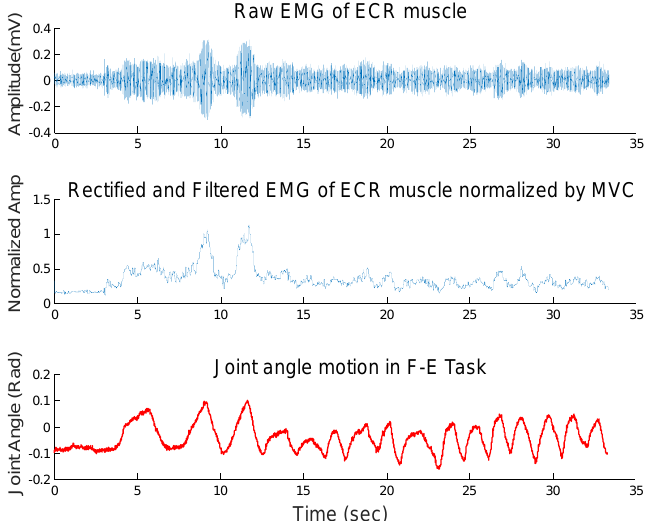
Figure 6. Steps of EMG pre-processing illustrated on for an ECR muscle of the